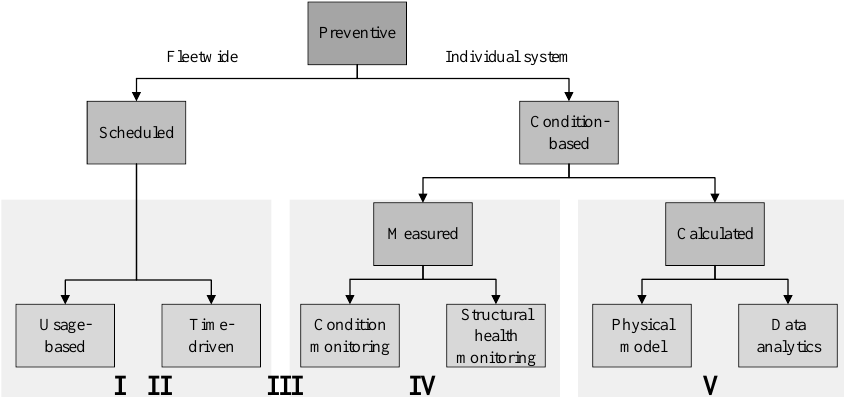
Figure 2. Relation between predictive maintenance policies and proposed types of MMs (and their clustering in approaches I to V).